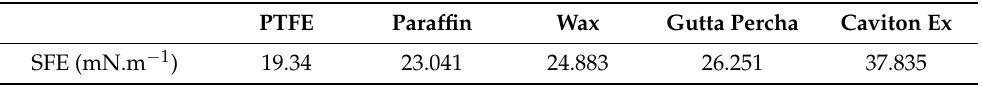
Table 3. Surface free energy of the materials calculated from the data of the contact angle